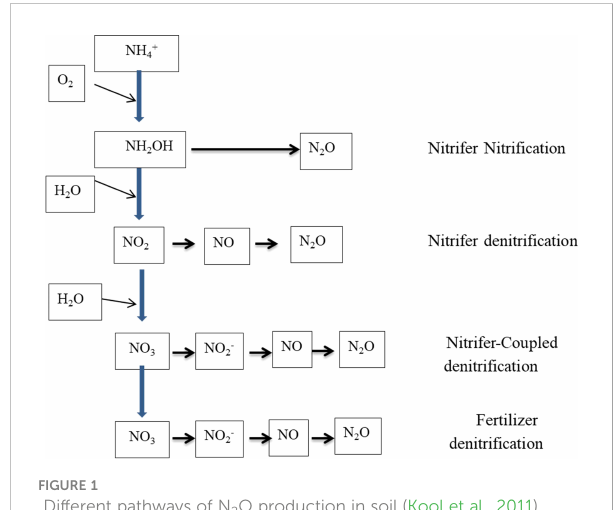
FIGURE 1 Different pathways of N 2 O production in soil (Kool et al.,